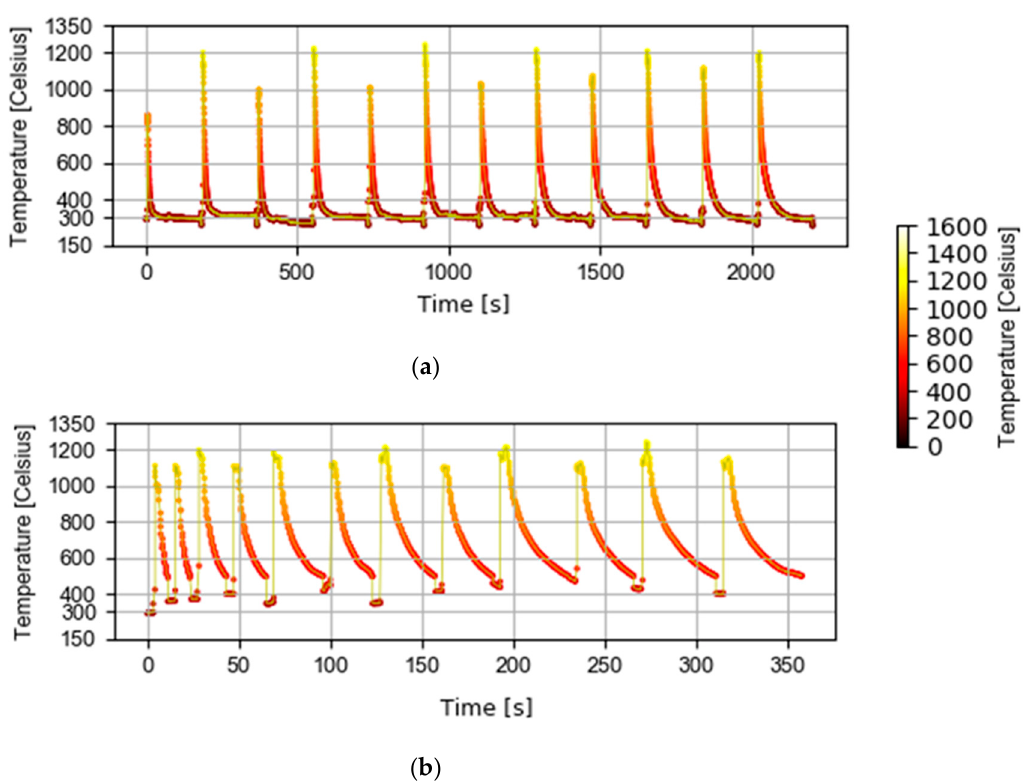
Figure 5. Surface temperature on the interlayer cooling time with strategies ( a ) A_ICS and ( b ) A_COS .